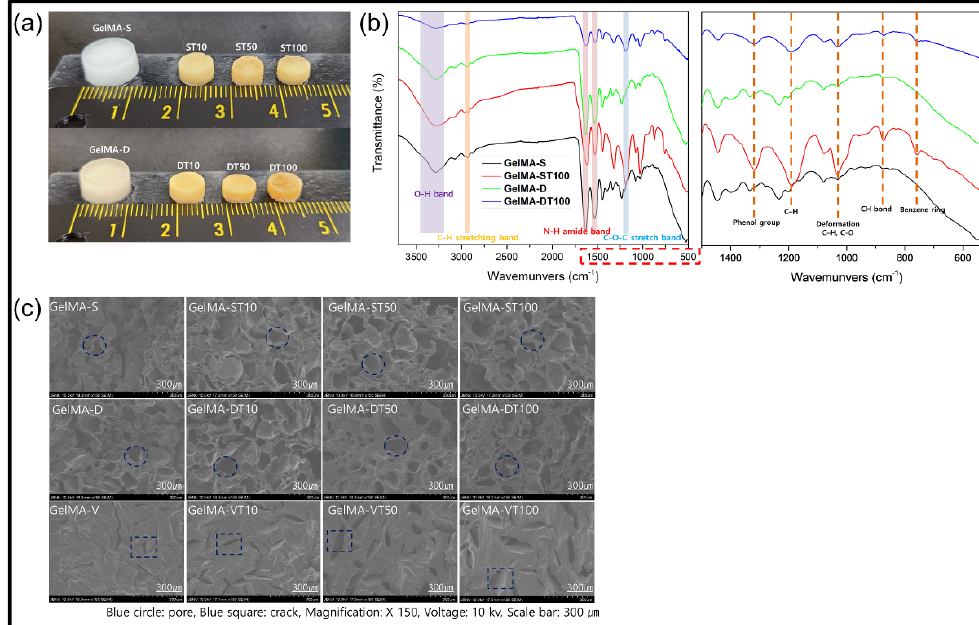
Figure 2. ( a ) The representative morphological changes from pristine GelMA hydrogels (left) to GelMA-TA (right) after a 24 h incubation in TA solution. Concentrations of GelMA and TA are 15% ( w / v ), and 10%, 50%, 100% ( w / v ), respectively. ( b ) FT-IR spectra of hydrogels. ( c ) FE-SEM of GelMA hydrogels, and GelMA-TA hydrogel 10%, 50%, 100% TA, 24 h treatment time. Red circles indicate pores, and squares indicate cracks. The image was measured using a voltage of 10 kv, the magnification was 150 × , and the scale bar was 300 µm.